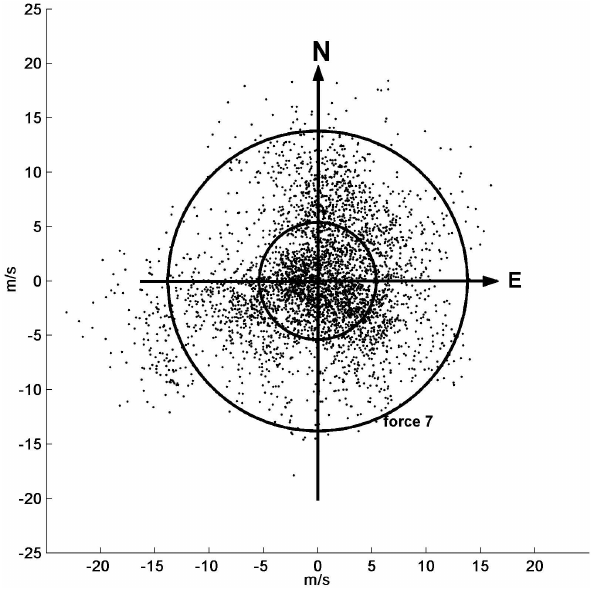
Fig. 6. Scatter plot of hourly wind speed data. Most of the data are concentrated inside the first circle indicating wind speed values below force